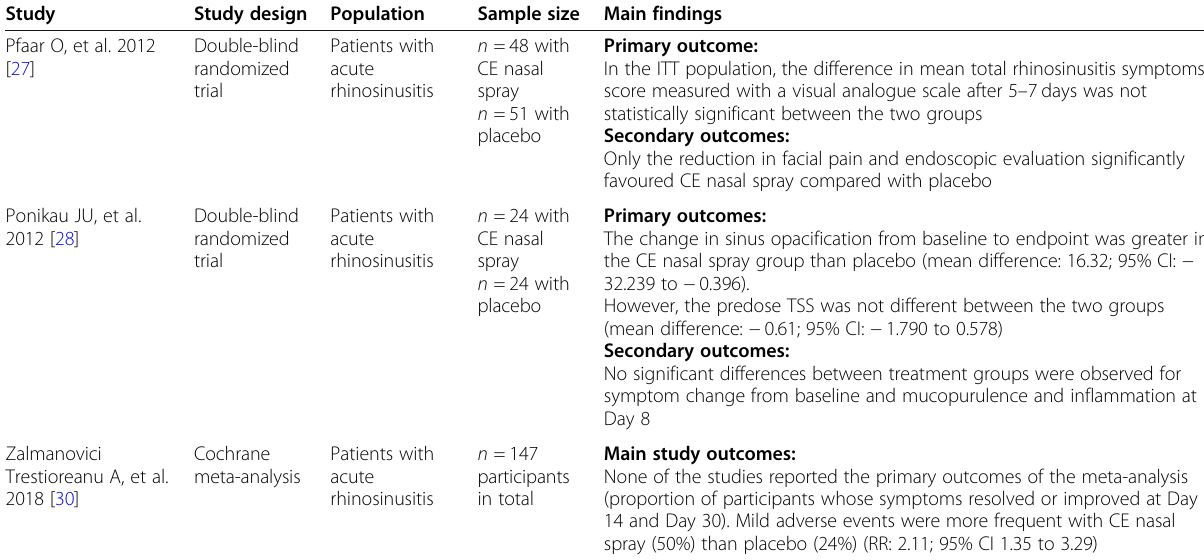
Table 3 Clinical studies with Cyclamen europaeum nasal